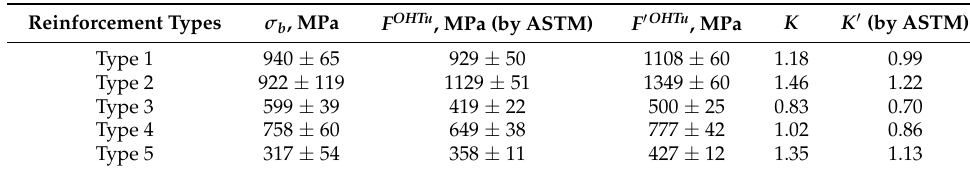
Table 4. Test results on the strength variance coefficient for carbon fiber specimens with holes and without holes.